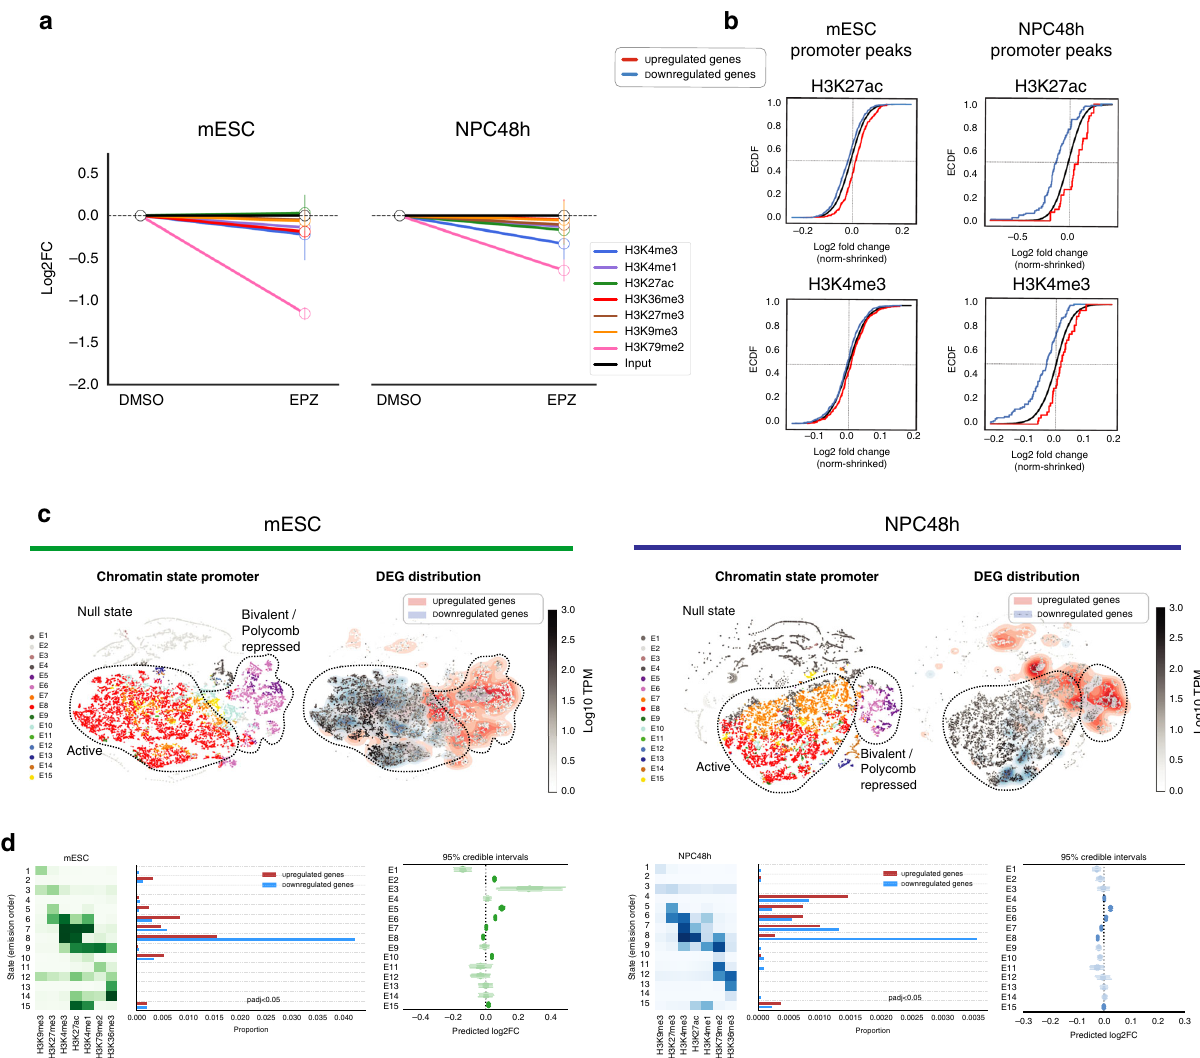
Fig. 4 DOT1L inactivation results in local epigenetic changes and upregulation of Polycomb repressed genes in NPC48h. a Log2 fold-changes of global scaling factors estimated via RELACS in EPZ-treated cells with respect to DMSO levels, for the seven histone modi fi cations included in this study for mESC (left) and NPC48h (right). b Promoter-associated active marks change consistently with EPZ-induced transcriptional dynamics. Upper panel: empirical cumulative density function (ECDF) of log2 fold-change of H3K27ac (top) and H3K4me3 (bottom) peaks overlapping promoter (TSS − 1000 bp, + 500 bp) of differentially expressed genes (EPZ vs DMSO, adjusted p -value < 0.05) in mESC (left) and NPC48h (right). The red line shows the ECDF of log2 fold- change of peaks overlapping promoters of upregulated genes upon EPZ treatment, while the blue and black line depicts the same information for downregulated genes and all annotated genes respectively. Transcriptionally affected genes upon EPZ treatment show a corresponding gain/loss of H3K27ac and H3K4me3 on their promoters. The epigenetic response is evident in NPC48h, while is almost absent in mESC. c Dimensionality reduction (tSNE) of the chromatin state signature of protein-coding genes for mESC (left) and NPC48h (right). Genes are represented as dots. For each cell type, color-code is based on the most abundant chromatin state present in the promoter region on the left map. On the right map, color-code is a gradient mapping the expression level of each gene. A 2D kernel density plot was over-imposed to show the distribution of differentially expressed genes (adjusted p -value < 0.05) on the tSNE map. d Promoter chromatin state is weakly associated with transcriptional deregulation. For mESC (left) and NPC48h (right), heatmap summarizing the emission probability of the hidden Markov model, next to a histogram showing the proportion of differentially expressed genes (adjusted p -value < 0.05) classi fi ed according to the the most abundant promoter chromatin state. Next, a plot showing the expected log2 fold-change posterior distribution (95% credible interval) of each group of genes sharing the same most represented chromatin state in the promoter. Log2 fold-change distributions of states not associated with promoters are shaded. For each group, the expected mean expression log2 fold-changes is close to 0, suggesting that a small fraction of genes in each group is transcriptionally